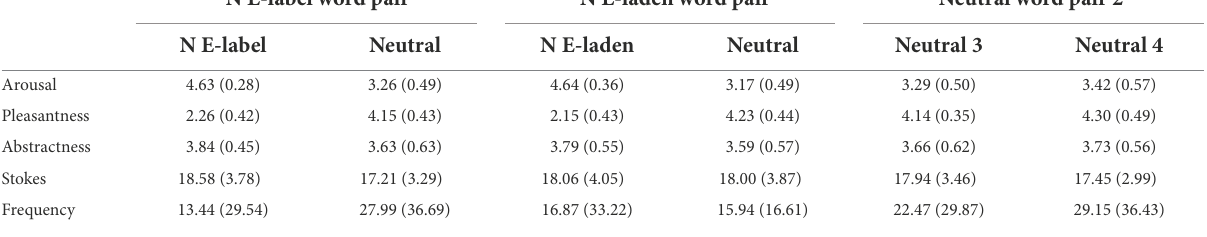
TABLE 1B The descriptive statistics of negative and neutral word pairs. N E-label word